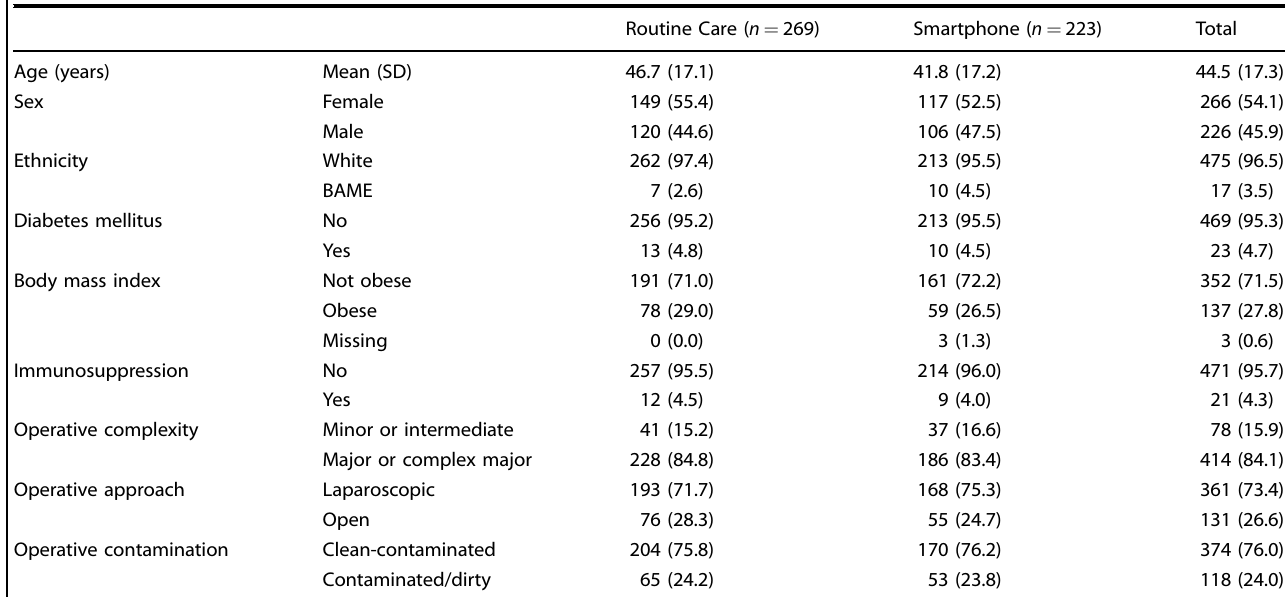
Table 1. Demographic and clinical characteristics of trial